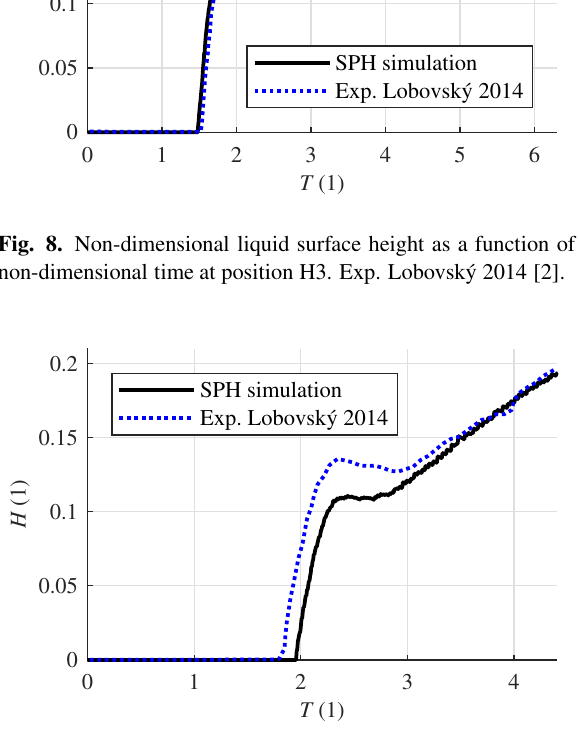
Fig. 9. Non-dimensional liquid surface height as a function of non-dimensional time at position H4. Exp. Lobovský 2014